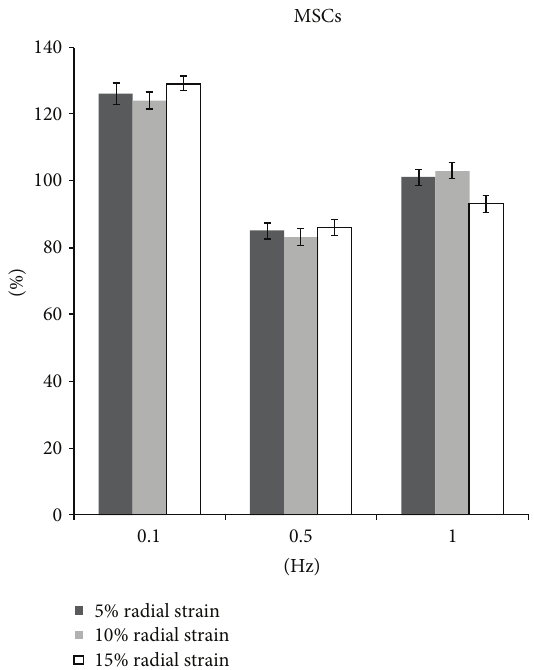
Figure 10: The collagen production of MSCs after radial stretch